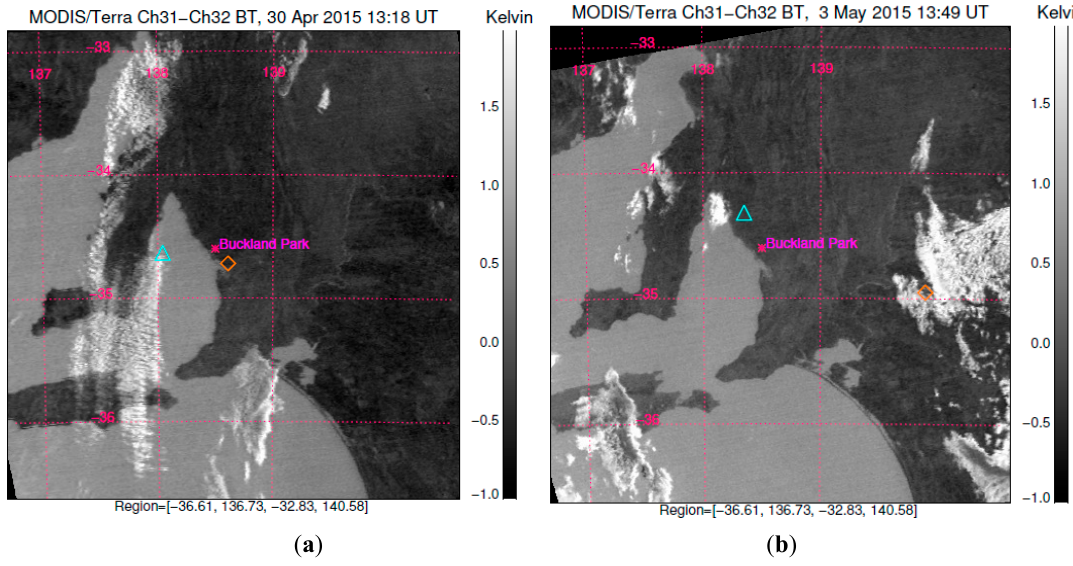
Figure 10. Brightness temperature difference between Moderate Resolution Imaging Spectroradiometer (MODIS) infrared channels 31 (11 µ m) and 32 (12 µ m) for the nearest overpasses to the Buckland Park lidar measurements on ( a ) 30 April and ( b ) 3 May 2015. The orange open diamond marks the location of the 11:00 UT radiosonde launch for each day when it reached a height of approximately 12 km for ( a ) and 15 km for ( b ) (corresponding to the approximate heights of the identified volcanic aerosol layers in Figure 1). The light blue open triangle indicates the location of the nearest AIRS granule to the lidar site for overpasses on 30 April at 16:29 UT for ( a ) and 3 May at 15:27 UT for ( b ). The scenes span approximately 355 km (E-W) by 420 km (N-S).